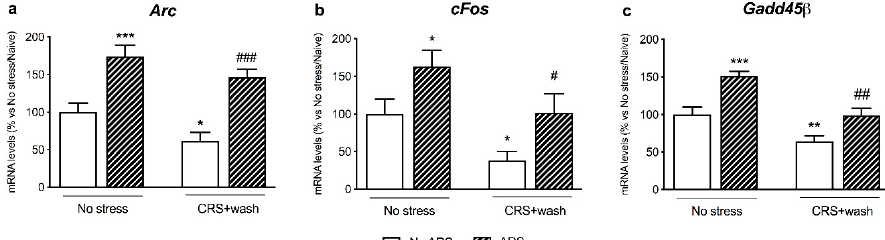
Figure 2. Analysis of Arc (panel a ), cFos (panel b ), and Gadd45 β (panel c ): mRNA levels in the prefrontal cortex of chronically stressed rats (CRS) exposed to an acute challenge (ARS) after 3 weeks of washout (wash). The data, expressed as a percent change of No stress / No ARS animals, are the mean ± SEM. * p < 0.05, ** p < 0.01, *** p < 0.001 vs. No stress / No ARS ; # p < 0.05, ## p < 0.01, ### p < 0.001 vs. CRS + washout / No ARS (two-way ANOVA with PLSD).